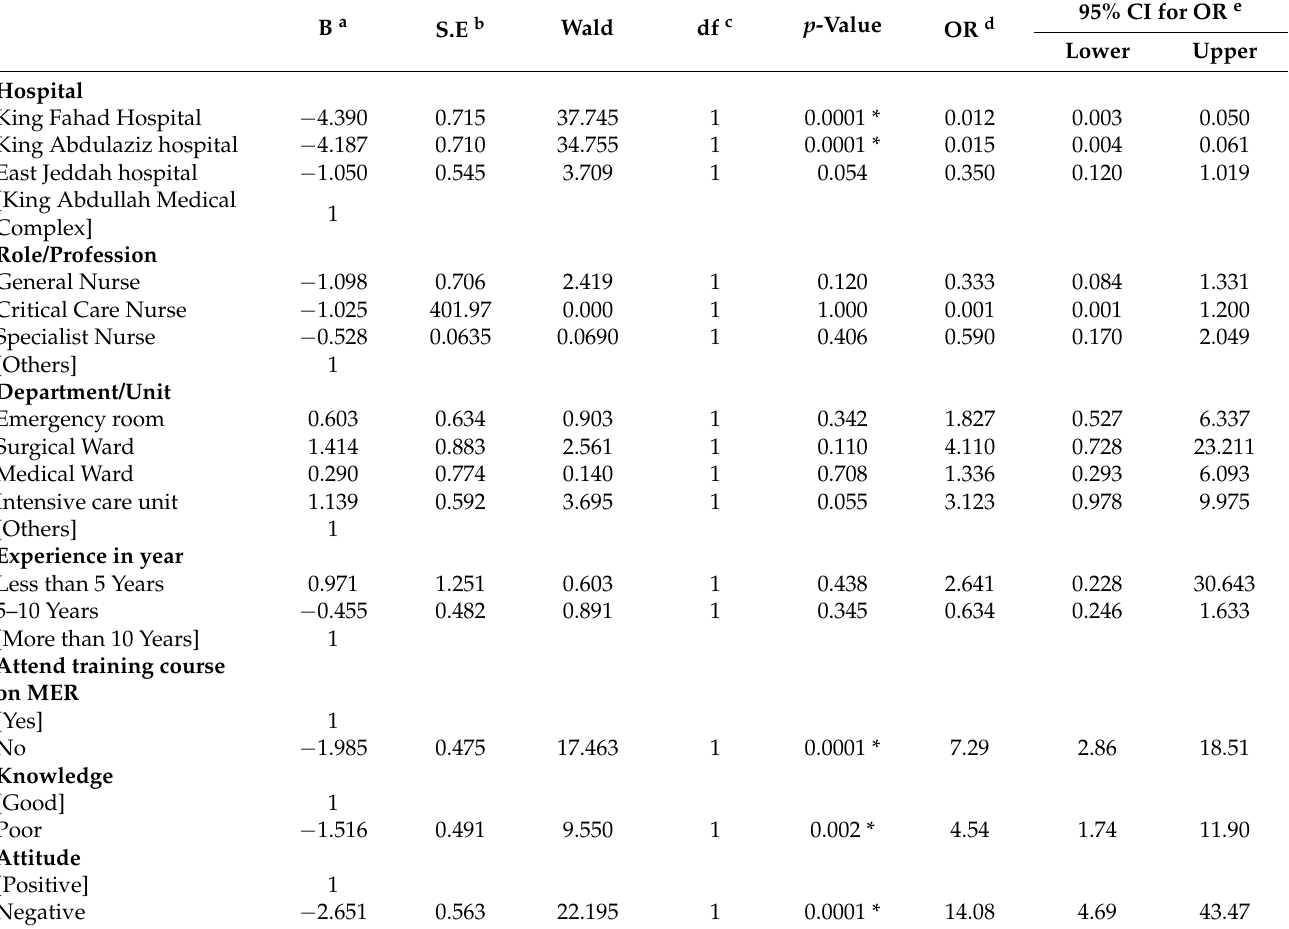
Table 6. Predictors of medication error among nurses from major hospitals in Jeddah, Saudi Arabia. B